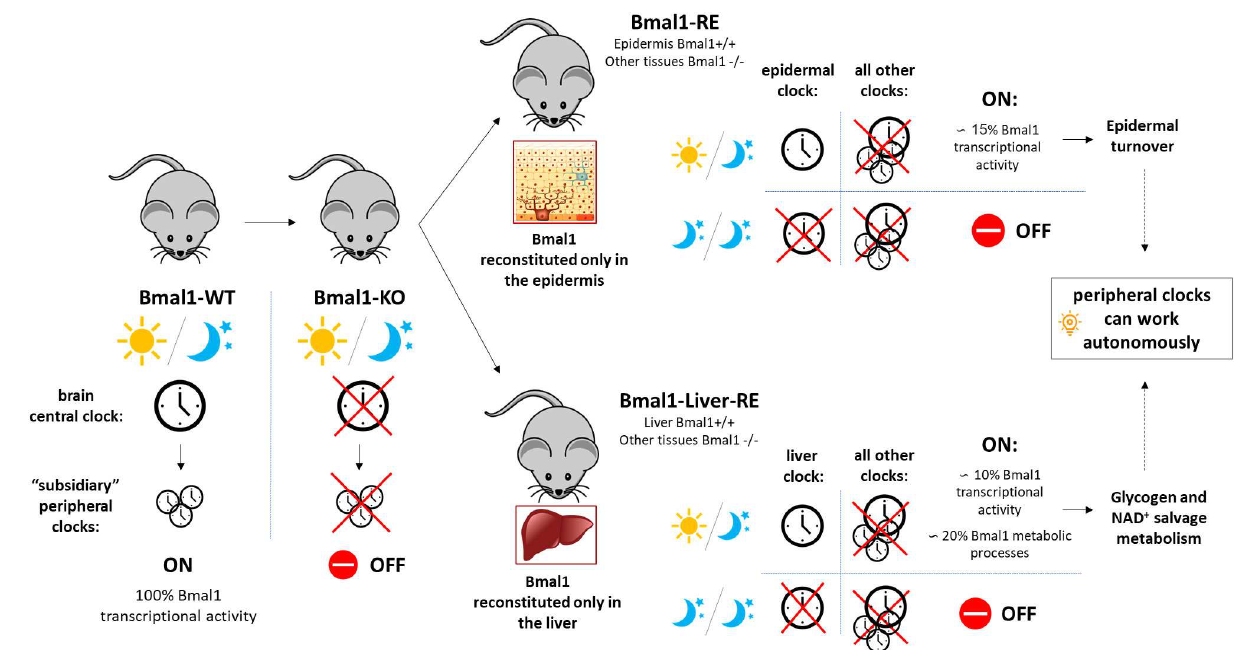
FIGURE 1 | Schematic representation of the main findings from the dual publication (Koronowski et al., 2019; Welz et al., 2019) commented. The mouse model reconstituting Bmal1 expression exclusively in the epidermis (Bmal1-RE mouse) or the liver (Liver-RE mouse) was generated from a conventional full-body Bmal1 knockout mouse (Bmal1-KO). In mammals, the brain central clock works as a master circadian coordinator of the rest of circadian clocks in the body. The autonomous responses in Bmal1 reconstituted organs (epidermis or liver) ensured basic homeostasis of the organs (e.g., epidermal turnover, glycogen metabolism) and were only dependent on inputs of light and darkness. WT, wild